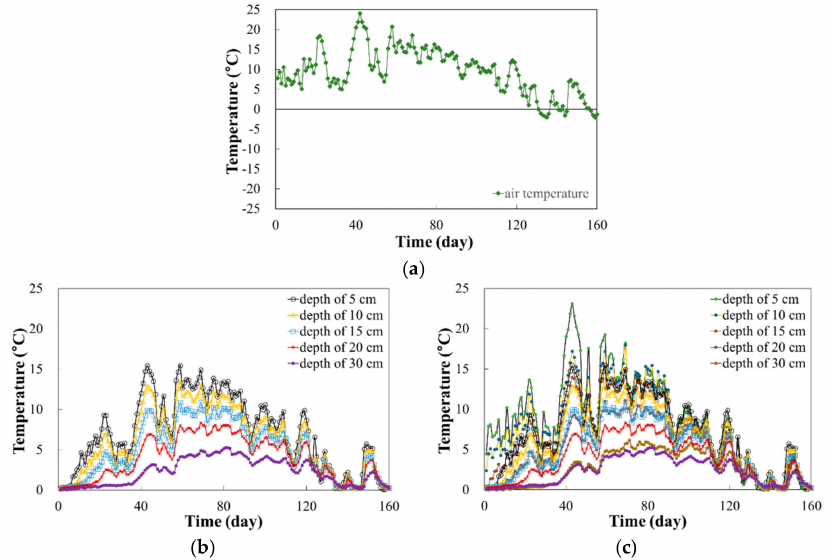
Figure 3. Temperature measurements of ( a ) air temperature above 1.2 m from the ground surface; and soil temperatures at the ( b ) site A and ( c ) site B.